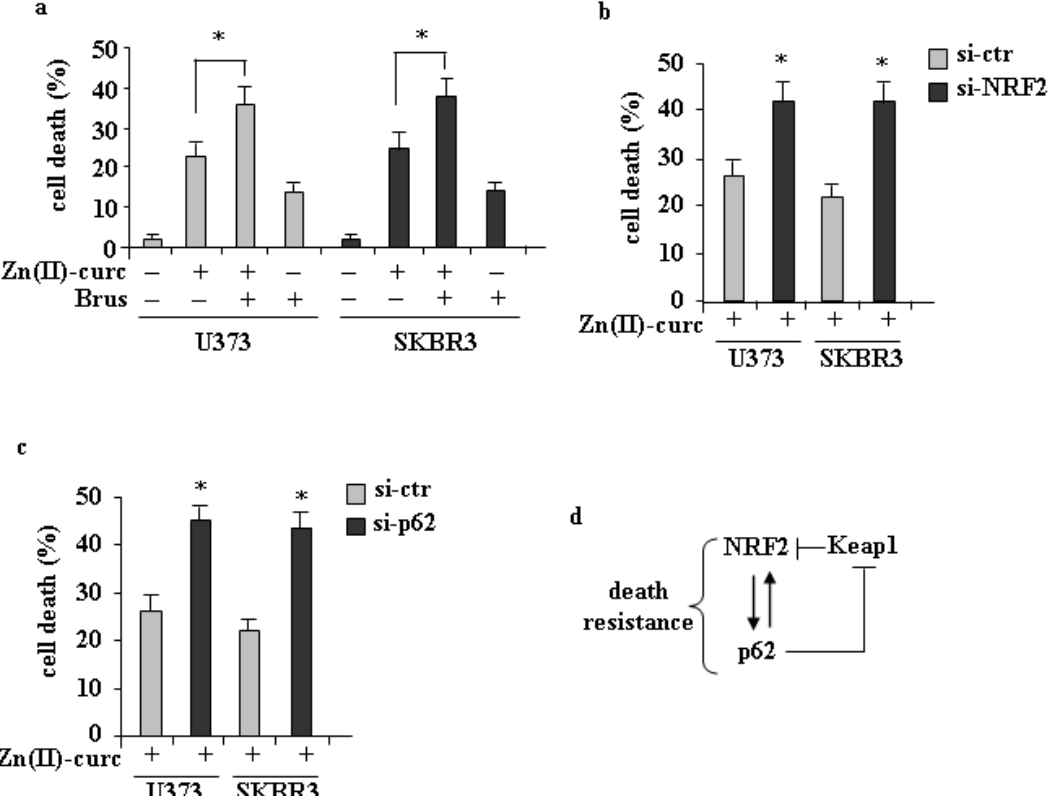
Figure 4. Inhibition of NRF2/p62 axis increases sensitivity to Zn–curc-induced cell death ( a ) U373 and SKBR3 cells were pre-treated with brusatol (Brus, 100 nM for 4 h) and then treated with Zn–curc (100 μg/mL) for 24 h. Cell viability was measured by trypan blue exclusion assay and expressed as percentage ± SD of three independent experiments. ( b ) U373 and SKBR3 cells, transfected with siRNA control (si-ctr) and siNrf2 or ( c ) sip62for 36 h, were then treated with Zn–curc (100 μg/mL) for 24 h before assaying cell viability as in (a). * p ≤ 0.05. ( d ) Schematic representation of the interplay between p62/Keap1/NRF2 and the biological outcome.